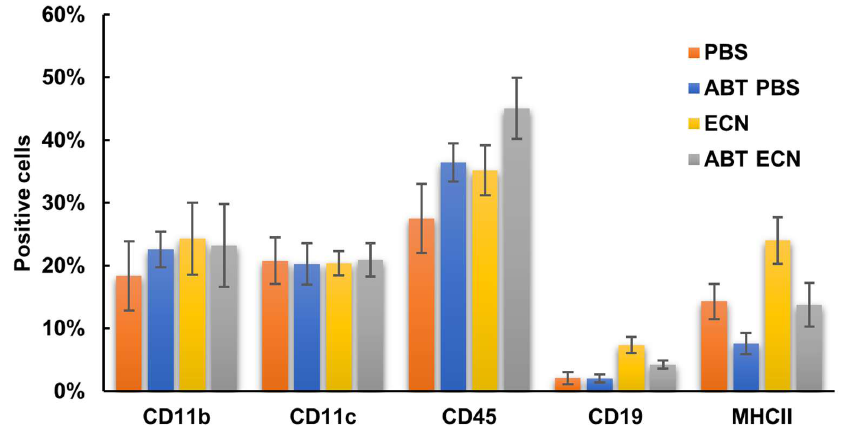
Figure 4. Percent [%] of CD11b-, CD11c-, CD45-, CD19- or MHCII-positive cells in tumor tissue